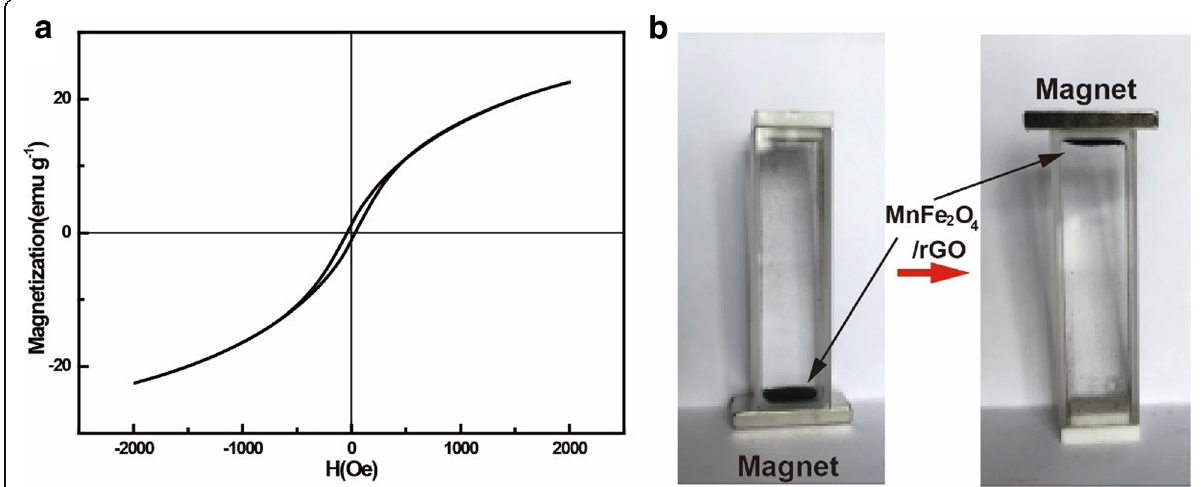
Fig. 3 Magnetic property of the MnFe2O4/rGO nanocomposite. a Hysteresis loop and ( b ) magnetic separation of the nanocomposite from water